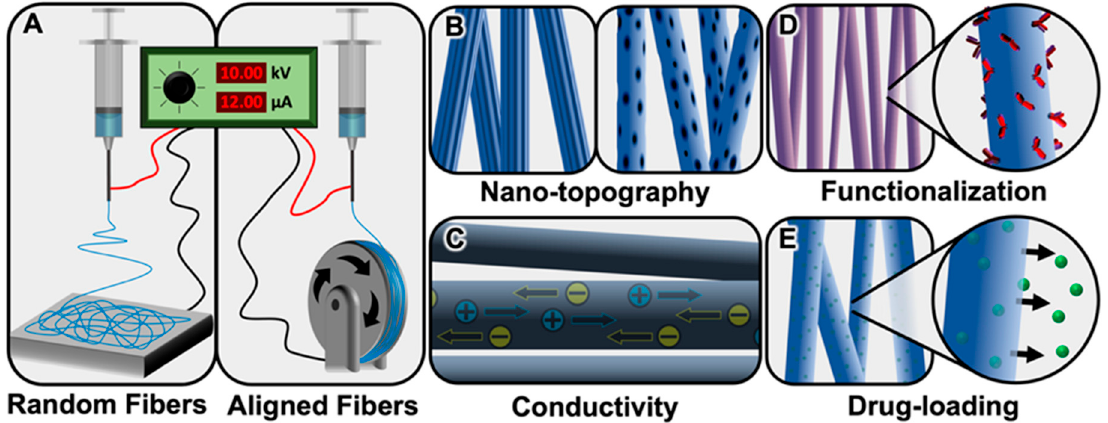
Figure 1. Electrospinning apparatus configurations and examples of electrospun fiber features that affect glial cell behavior. ( A ) Electrospinning apparatus configuration for generating randomly oriented fibers on a flat plate (left) and aligned fibers on a rotating mandrel (right). Electrospinning apparatus parameters and the materials used for electrospinning can be tuned to alter fiber ( B ) nanotopography, ( C ) conductivity, ( D ) functionalization, or ( E ) drug-loading to engineer a desired cell response.